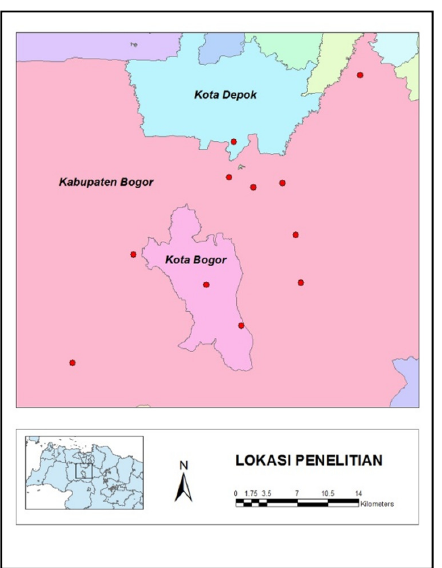
Fig 1. Distribution of GPS test